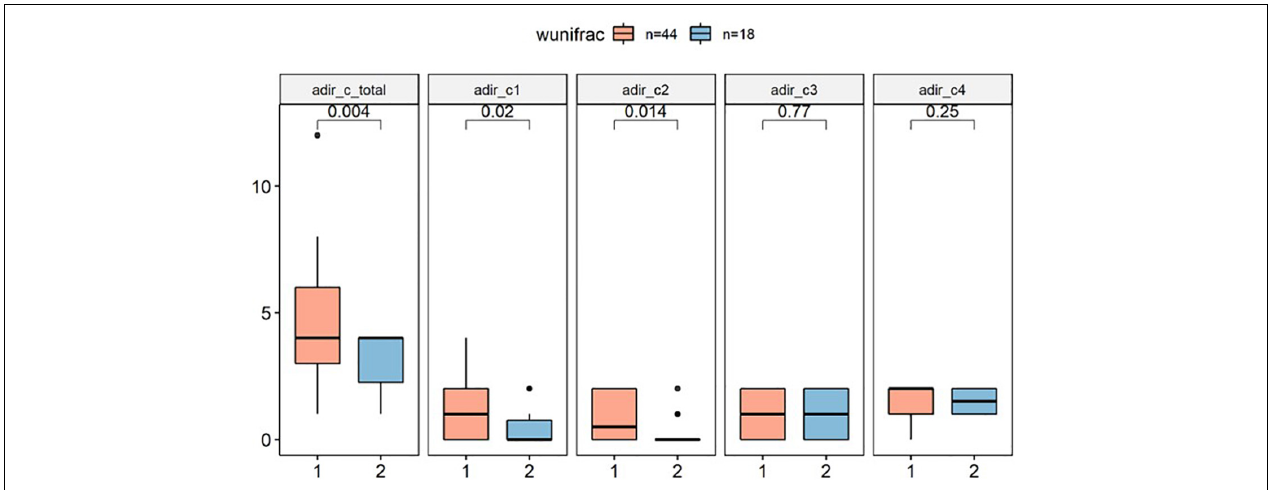
FIGURE 3 | ADI-R C score difference between clusters (wunifrac distance). ADI-R, Autism Diagnostic Interview-Revised. ADI-R C score: Restricted, Repetitive, and Stereotyped Patterns of Behavior, adir_cl: encompassing preoccupation or circumscribed pattern of interest. adir_c2: apparently compulsive adherence to nonfunctional routines or rituals. adir_c3: stereotyped and repetitive motor mannerism. adir_c4: Preoccupation with parts of objects or non-functional elements of